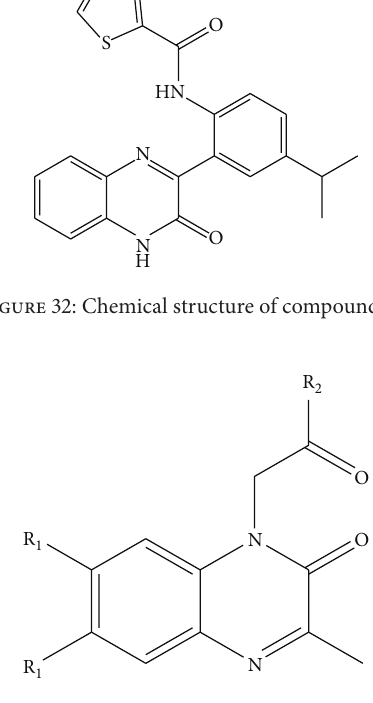
Figure 33: Chemical structure of compounds 81a – t